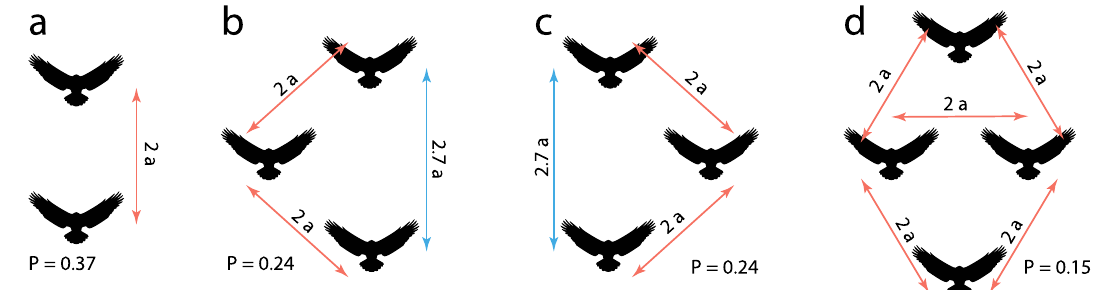
Figure 4. Optimal configurations for the group of two, three, and four agents moving with the same velocity (see SM for the optimal configurations of larger swarms). The results are obtained by the direct minimization of the total dissipation power (see Methods). The average dissipated power per agent is indicated in units of the power dissipated by a solely moving agent. Note that optimal configuration for the triplet has two symmetric realizations. Also note that the larger the swarm, the smaller the specific dissipation.